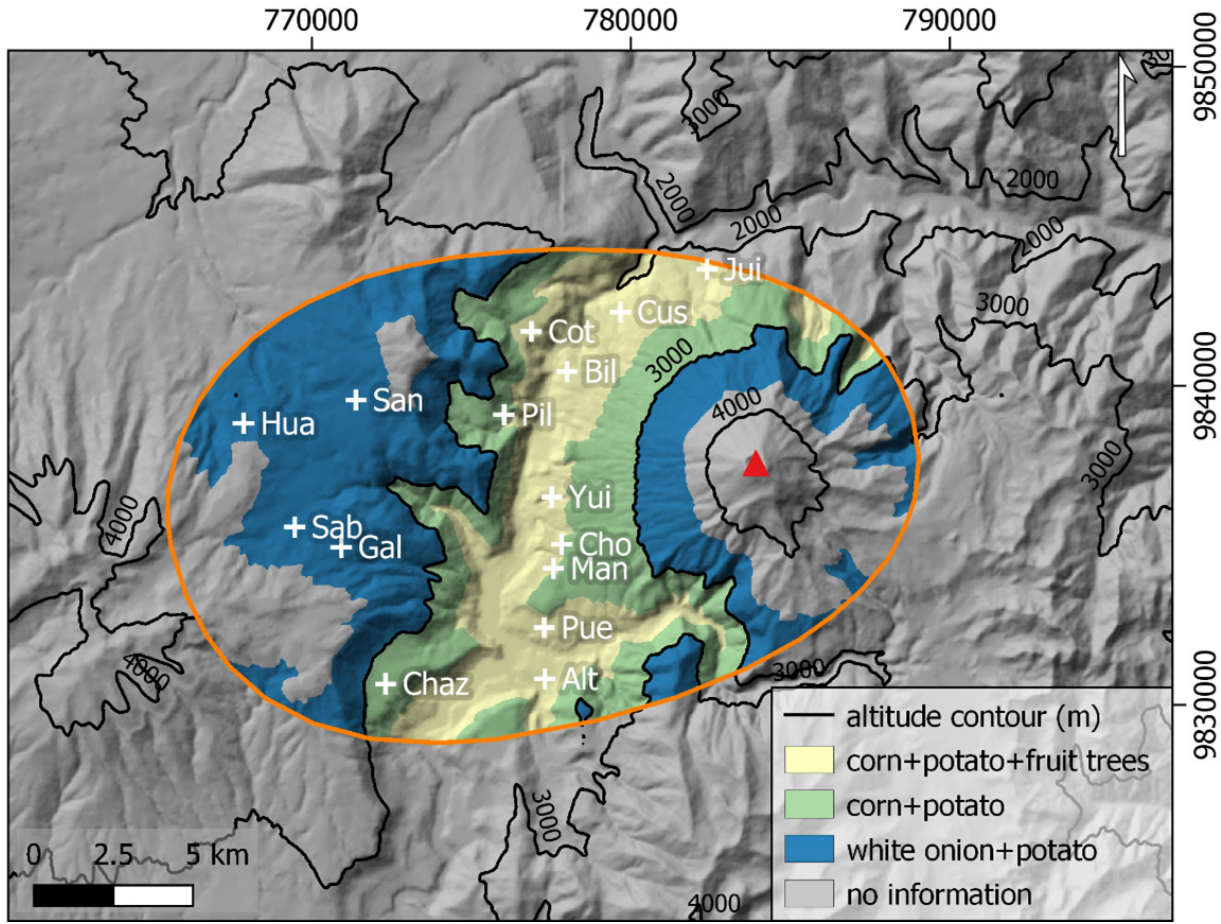
Figure 6: Zonation of crops within the surveyed area (delineated by the orange line). Three zones that differ by the main crop association are distinguished based on altitude: corn+potato+fruit trees, corn+potato, and white onion+potato at altitudes of ∼ 1900–2600, ∼ 2600–3000, and ∼ 3000–3600 m a.s.l., respectively. There is no in- formation for terrains situated at altitudes >3600 m a.s.l. Symbols and village names as in Figure